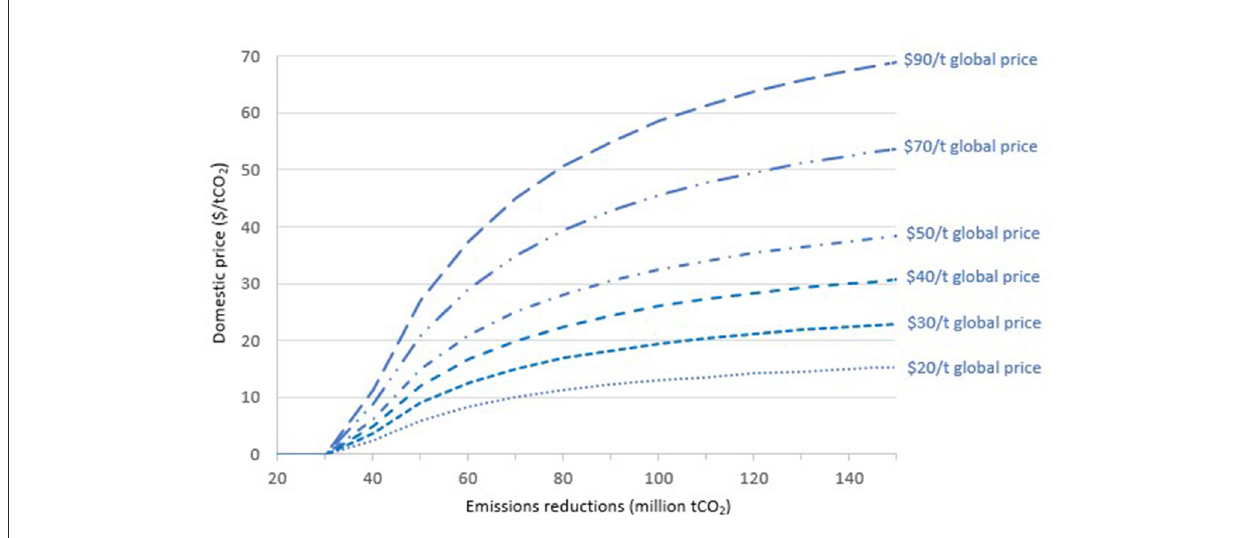
FIGURE3 Feasible combinations of domestic abatement prices and quantities consistent with break even, by different global prices for credits. Note: For each level of domestic prices paid for abatement, lines denote the minimum quantities of realized abatement that ensure break-even, given the indicated global price for credits. The minimum abatement requirement ( Q ) is assumed to be 35 million tCO 2 such that international payments are only made for abatement exceeding that level.